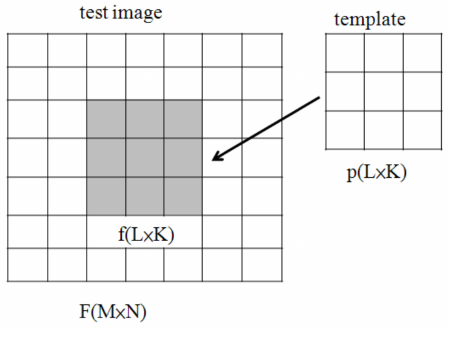
Figure 12. Match